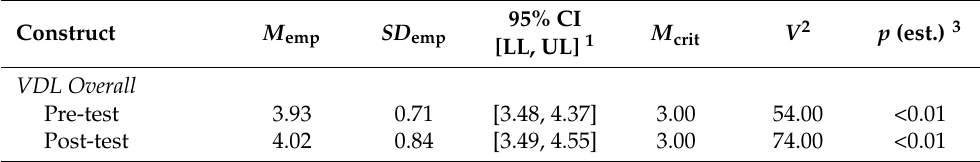
Table 8. Descriptive and inferential statistics regarding user acceptance.